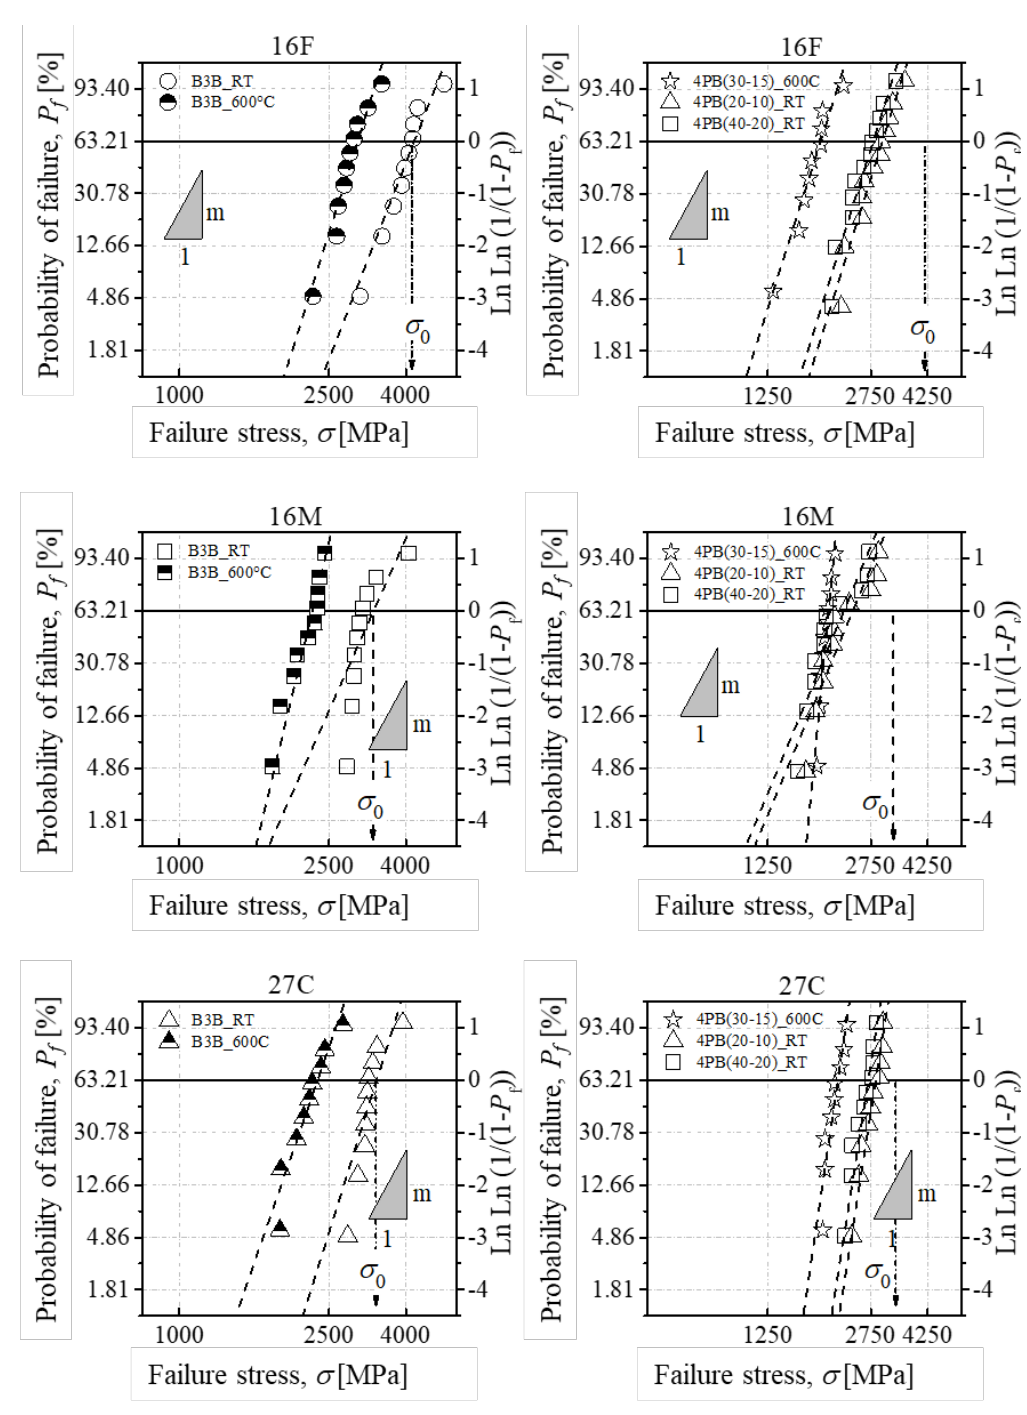
Figure 2. Weibull diagrams of the three cemented carbide grades subjected to B3B and 4PB tests at room temperature and 600 °C.